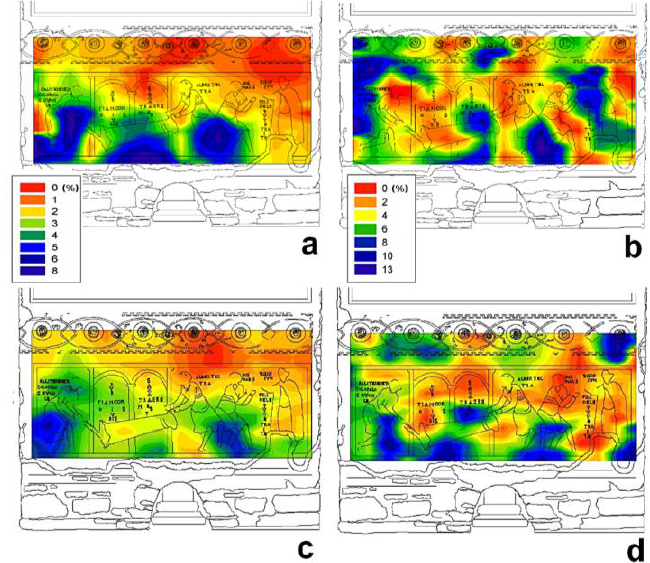
Figure 3. Moisture distribution maps obtained by unilateral NMR before ( a , b ) and after ( c , d ) intervention to reduce capillary rise of water through the wall. Left, maps collected at a depth of 0.5 cm, right, maps collected on superficial layer (0.1 cm) of the wall painting. Data adapted from